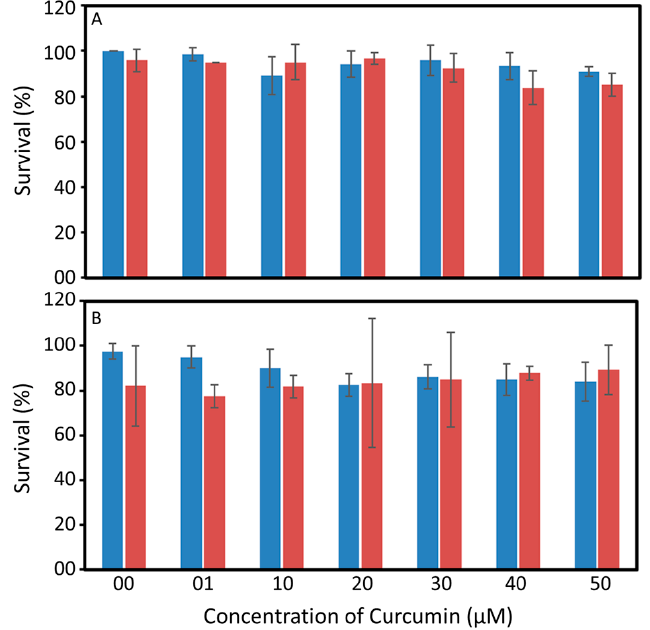
Figure 3. Toxicity of Curcumin (blue) and photoexcited curcumin (red) to Artemia nauplii ( A ) and post larvae of Penaeus monodon ( B ). Results are presented as average ± standard deviation (sd). The differences obtained in the toxicity were not statistically significant ( p > 0.05).